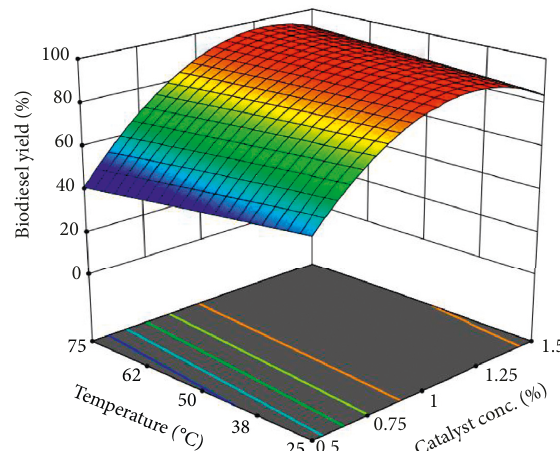
Figure 3: Effect of reaction temperature and catalyst concentration on the yield of biodiesel at ethanol to oil molar ratio of 7.5:1.